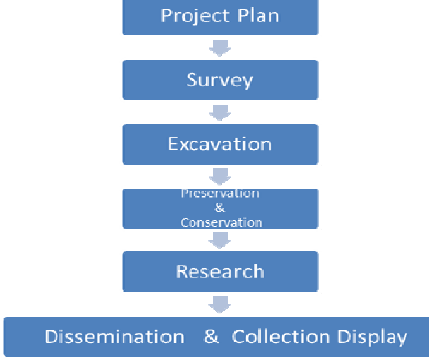
Figure 4.Underwater Archaeology